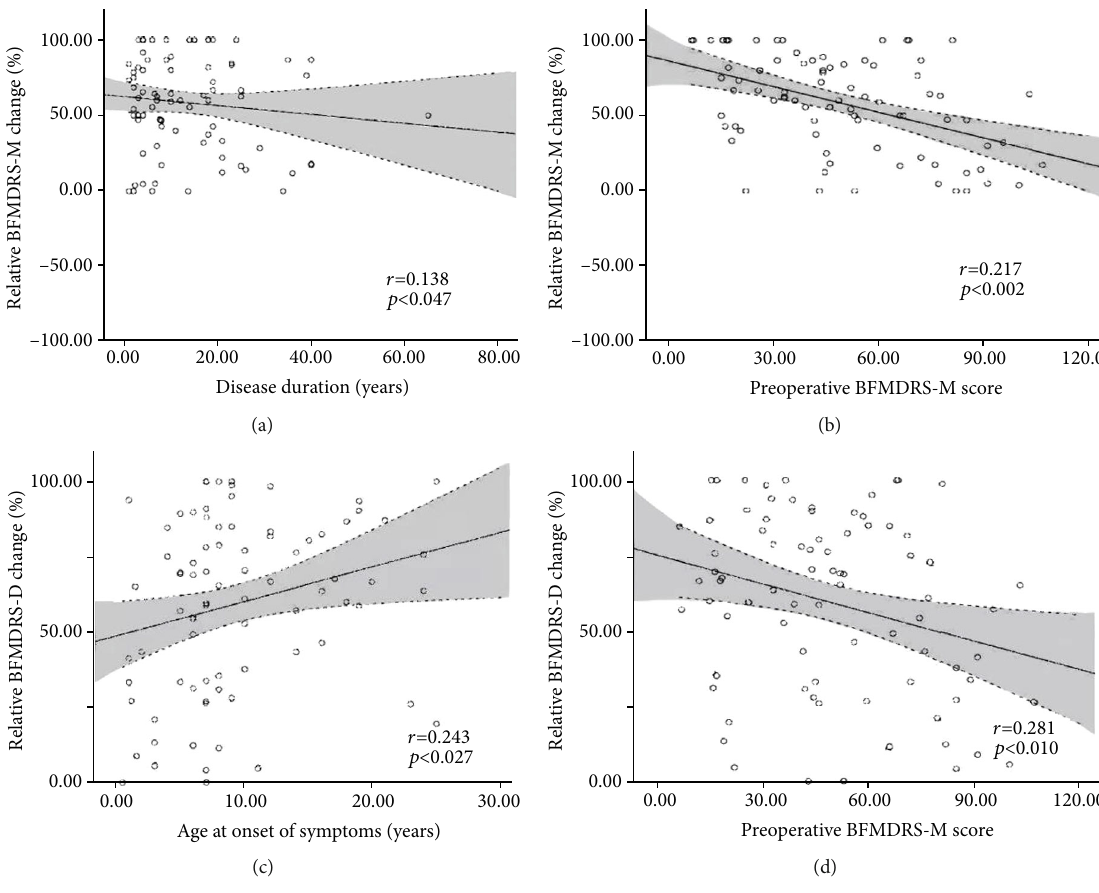
Figure 3: Potential predictive factors for relative improvement (%) in BFMDRS-M and BFMDRS-D under 3 years of follow-up visit. There were signi fi cant positive correlations between (a) disease duration and the relative improvement (%) in BFMDRS-M (Pearson r = − 0 : 138 , p = 0 : 047 ), (b) preoperative BFMDRS-M score ( r = − 0 : 217 , p = 0 : 002 ) and the relative improvement (%) in BFMDRS-M, (c) age at onset ( r = 0 : 243 , p = 0 : 027 ) and the relative improvement (%) in BFMDRS-D, and (d) preoperative BFMDRS-M score ( r = − 0 : 281 , p = 0 : 010 ) and the relative improvement (%) in BFMDRS-D. Dots: individual patient values; black solid line: linear regression line; area between the dotted lines: 95% con fi dence interval; BFMDRS: Burke – Fahn – Marsden Dystonia Rating Scale; BFMDRS-D: BFMDRS disability subscale; BFMDRS-M: BFMDRS movement